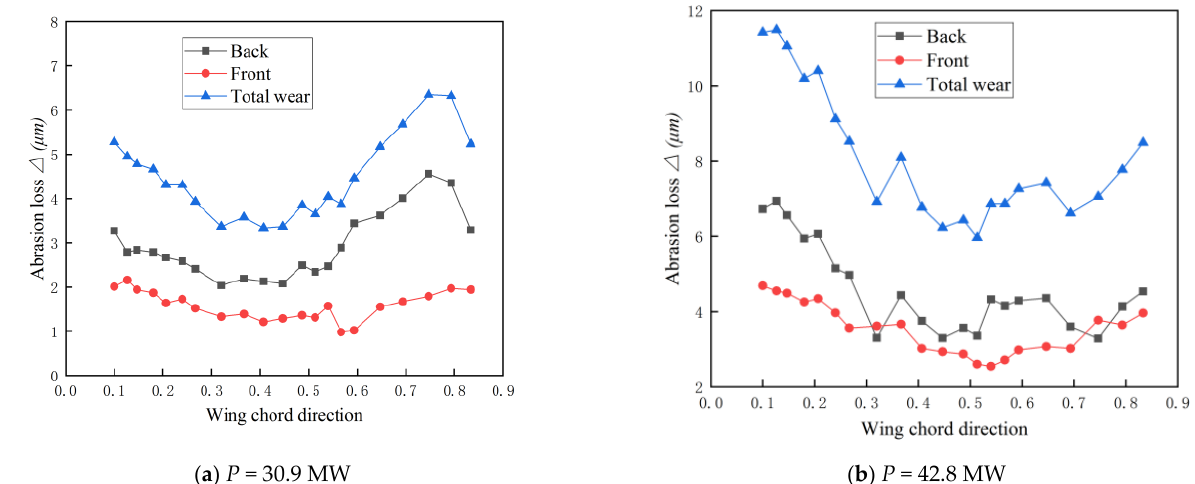
Figure 24. ( a , b ) Wear on the chord of different airfoil types (Tungsten